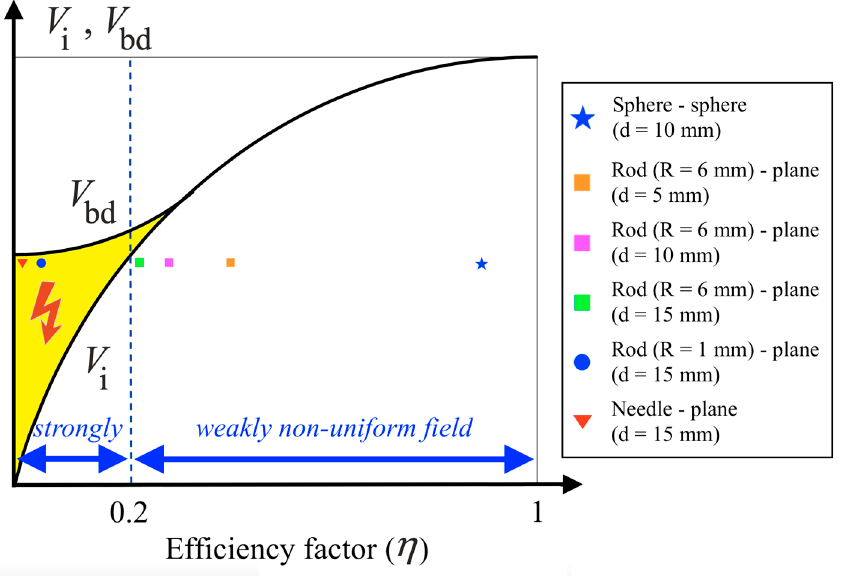
Figure 22. The efficiency factor calculated for different electrode systems and the relationship between efficiency factor, corona inception voltage and breakdown voltage.